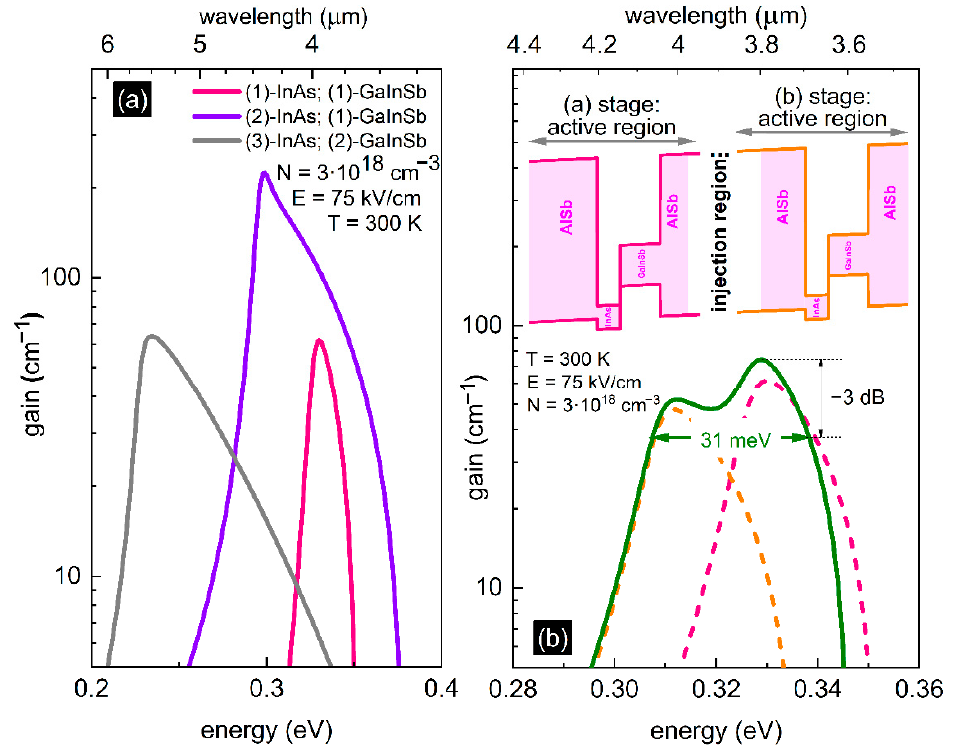
Figure 2. Optical gain spectra: ( a ) for one stage: AlSb/InAs/Ga x In 1 − x Sb/AlSb—pink solid line, AlSb/InAs/Ga x In 1 − x Sb/InAs/AlSb—violet solid line and AlSb/InAs/Ga x In 1 − x Sb/InAs/Ga x In 1 − x Sb/InAs/AlSb—gray solid line (x = 0.76; width of InAs layer equal to 2.0 nm); ( b ) for two stages, wherein each individual active region (1 stage) AlSb/InAs (2.0 nm-dashed pink line/2.1 nm-dashed orange line)/Ga 0.76 In 0.24 Sb (3.5 nm)/AlSb; broad combined gain (2 stage design)—solid green line.